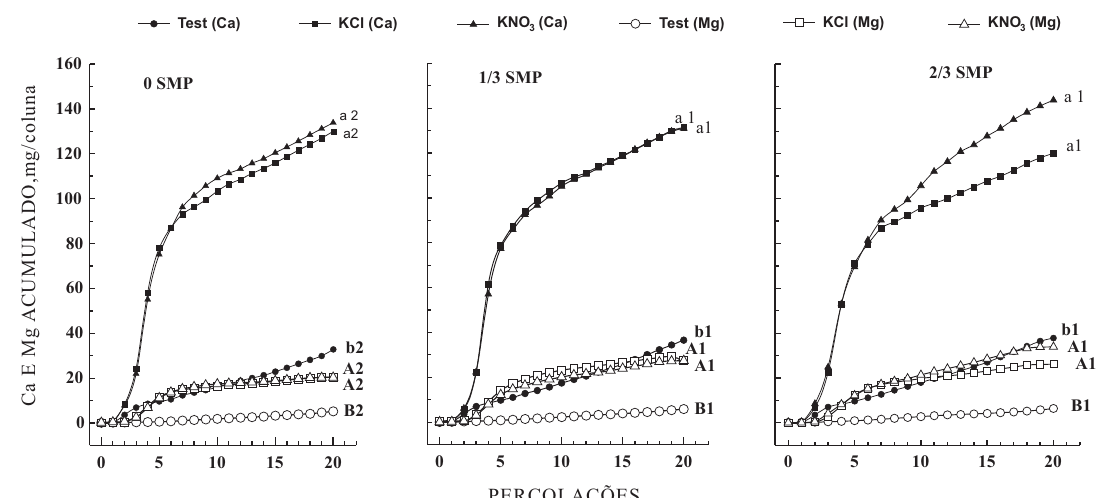
Figura 1. Quantidades de cálcio e magnésio percoladas em função da adição de doses de calcário (0, 1/3 e 2/ 3 da recomendação do método SMP para pH-H O 6,0) combinadas com sais de potássio aplicados na 2 superfície de um Cambissolo Húmico. Médias seguidas pela mesma letra ou número não diferem significativamente pelo teste de Tukey a 5 %; letras maiúsculas comparam os teores de Mg e letras minúsculas comparam os teores de Ca dentro de cada dose de calcário; números comparam o efeito dos sais entre as doses de